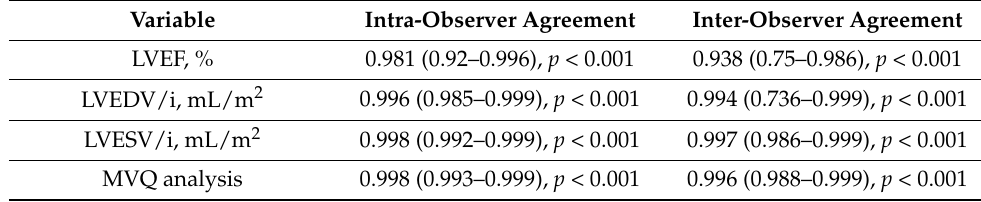
Table 3. Intra and inter-observer variability of echocardiographic measurements. Variable